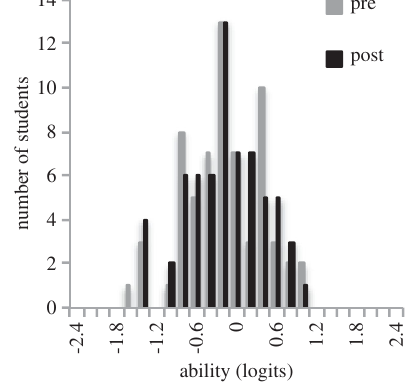
Δ θ versus h g i for classes with at least 25